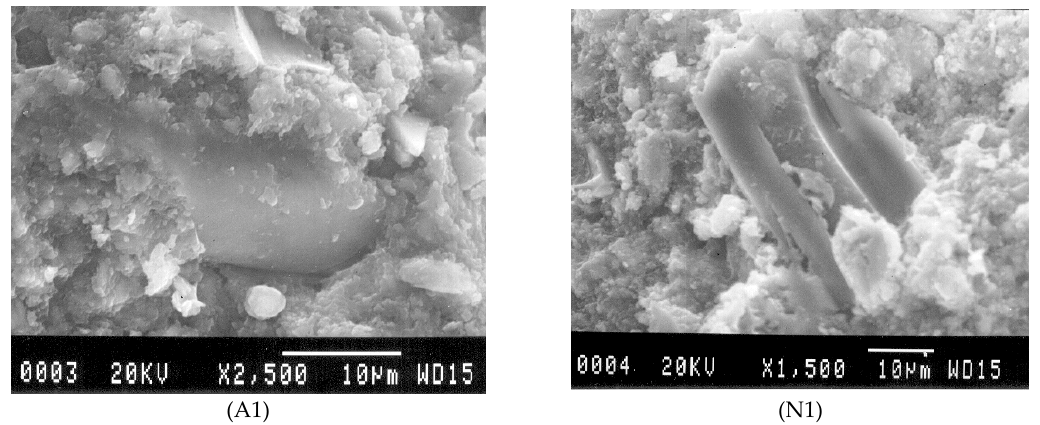
Figure 4. Crack around the rounded grain of mortar with A1 sand ( left ) and strong cohesion between the binder and rough grain in a mortar with N1 sand ( right ).